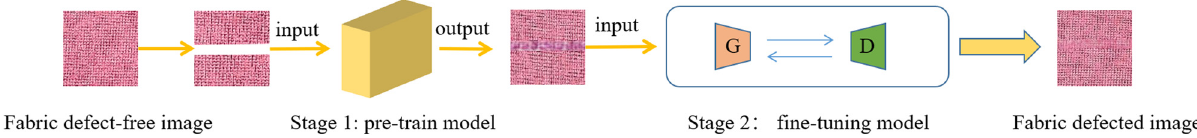
Figure 1: The overview of